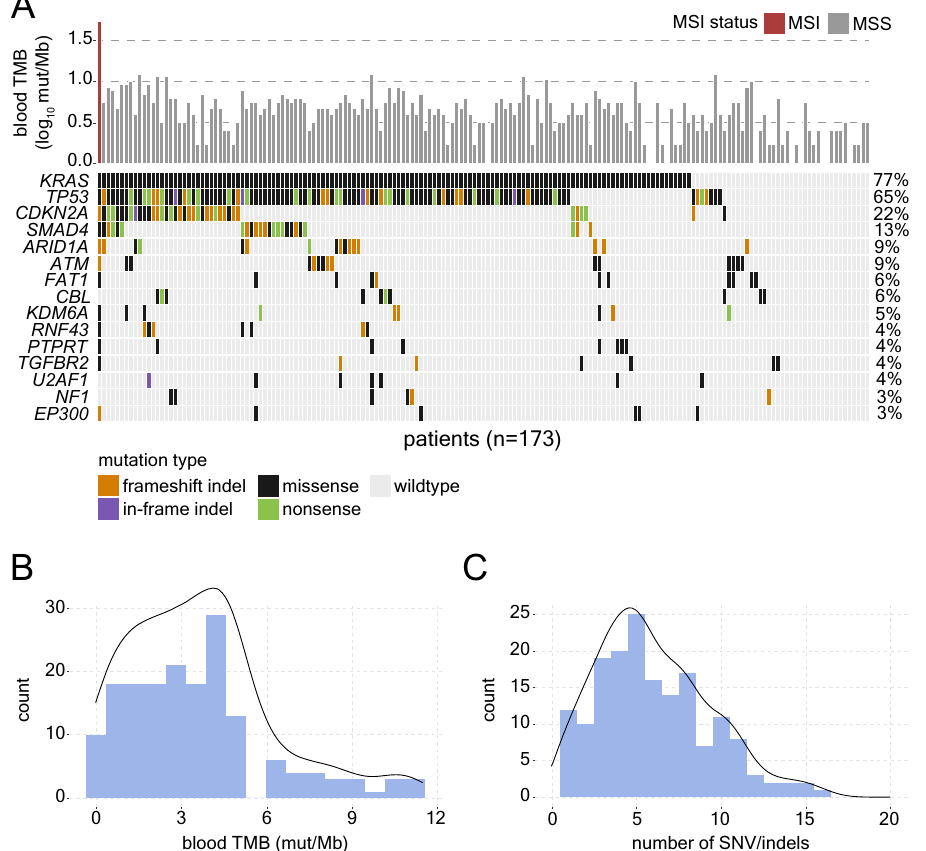
B Histogram with overlaid density curve showing distribution of blood tumor mutational burden levels across the cohort. C Histogram with overlaid density curve showing distribution of the number of SNV/indels detected by ctDNA sequencing. Source data are provided as a source data fi le.